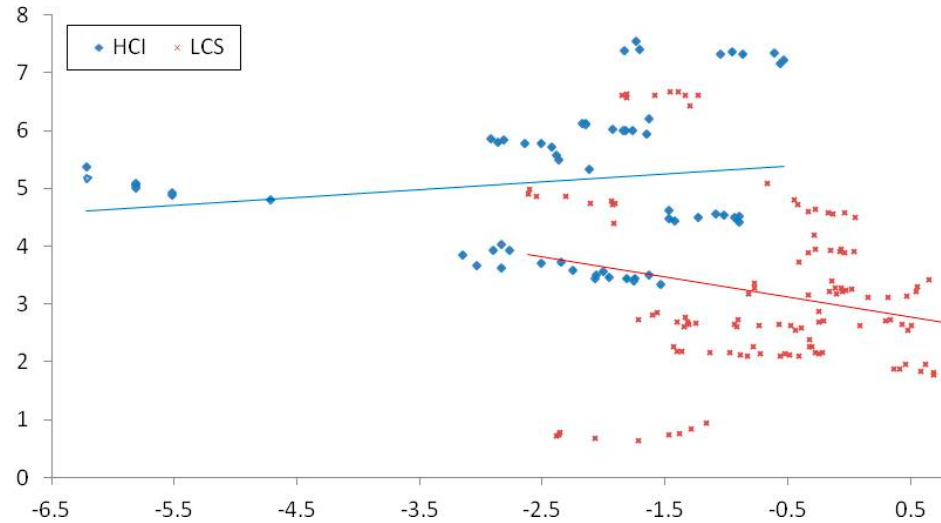
Figure 2. Scatter plot of trade openness vs. CO 2 emissions’ intensity for high-carbon sectors (HCSs) and low-carbon sectors (LCSs).